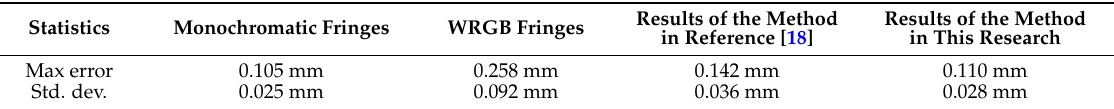
Table 1. Statistics of the measurement errors of a flat board. Figure 14. Measurement results of a flat board: 3D point clouds using ( a ) monochrome fringe; ( b ) color fringe pattern without correction; ( c ) the method in Reference [18]; ( d ) the proposed method; measurement error using ( e ) monochrome fringe; ( f ) color fringe pattern without correction; ( g ) the method in Reference [18]; ( h ) the proposed method.